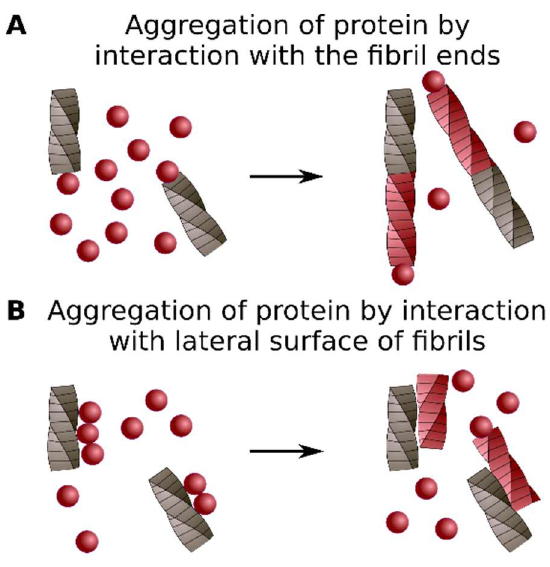
Figure 3. Cross-seeding mechanisms. Aggregation of the protein may be caused by interaction with fibril ends ( A ) or lateral sides ( B ). See details in the text.